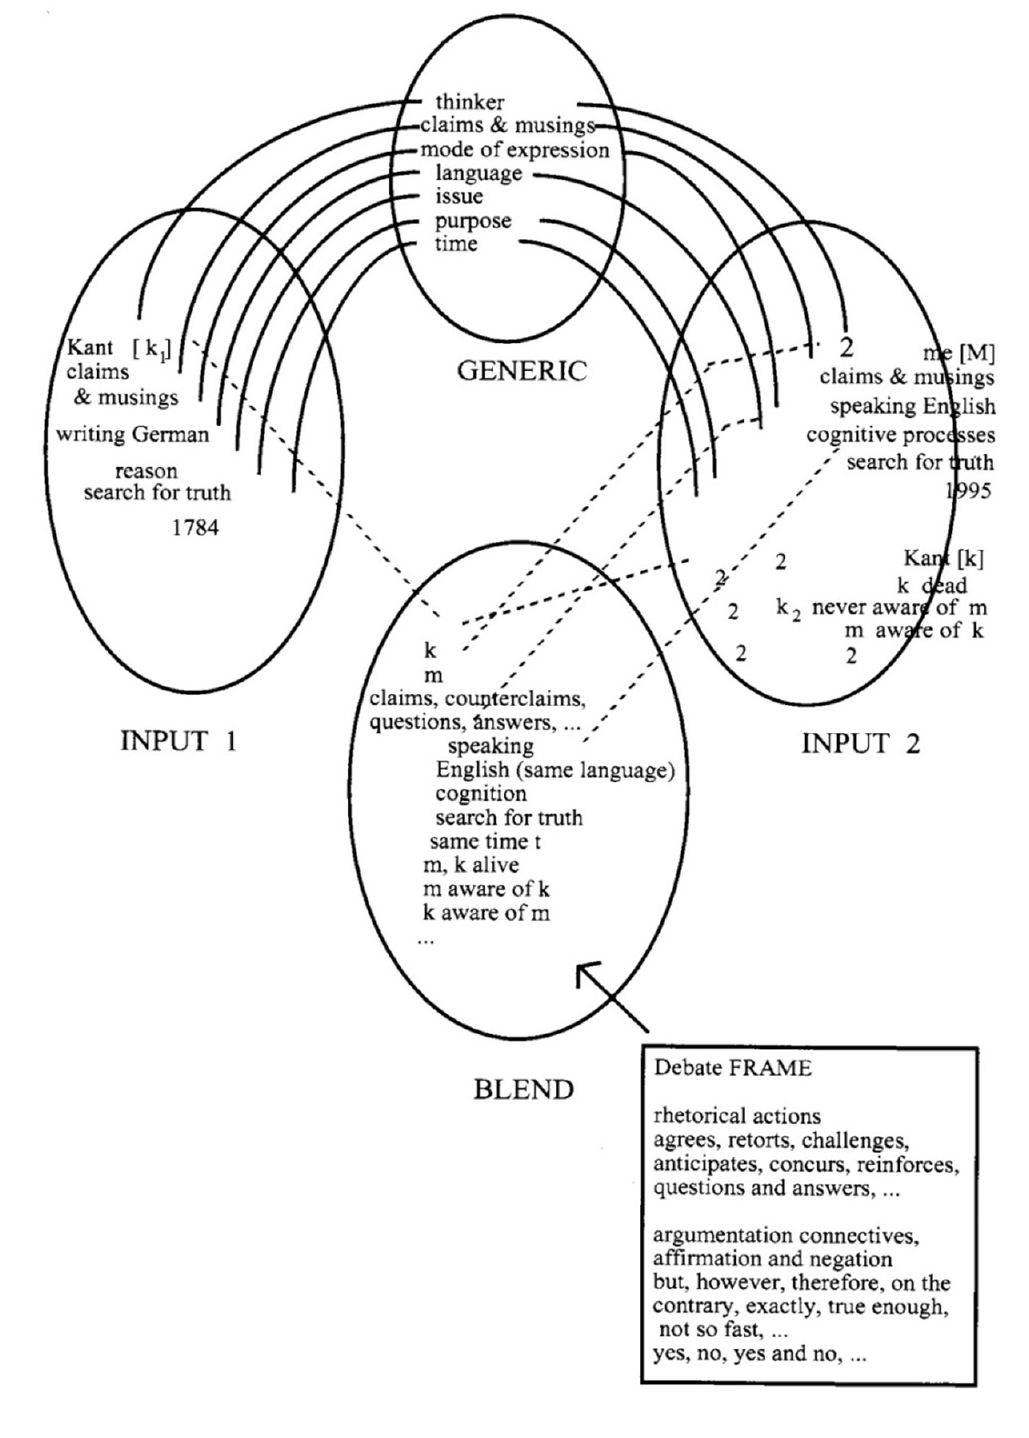
Figure 2. debate with kant